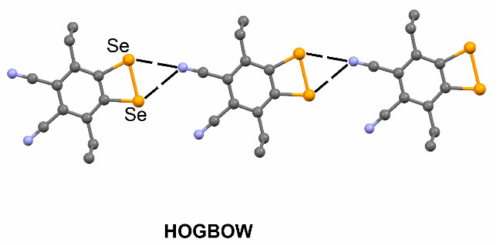
Figure 12. Ball-and-stick representation of the X-ray solid-state structure of HOGBOW showing the 1D supramolecular polymer. The ChBs are represented using dashed lines. H atoms omitted for